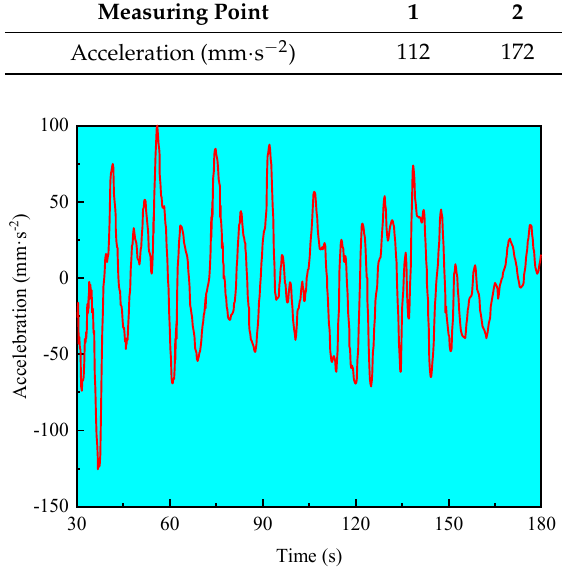
Figure 8. Typical measured acceleration time − history curve [34].